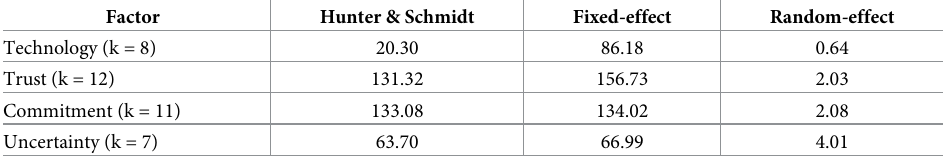
Table 9. Homogeneity test statistic for three